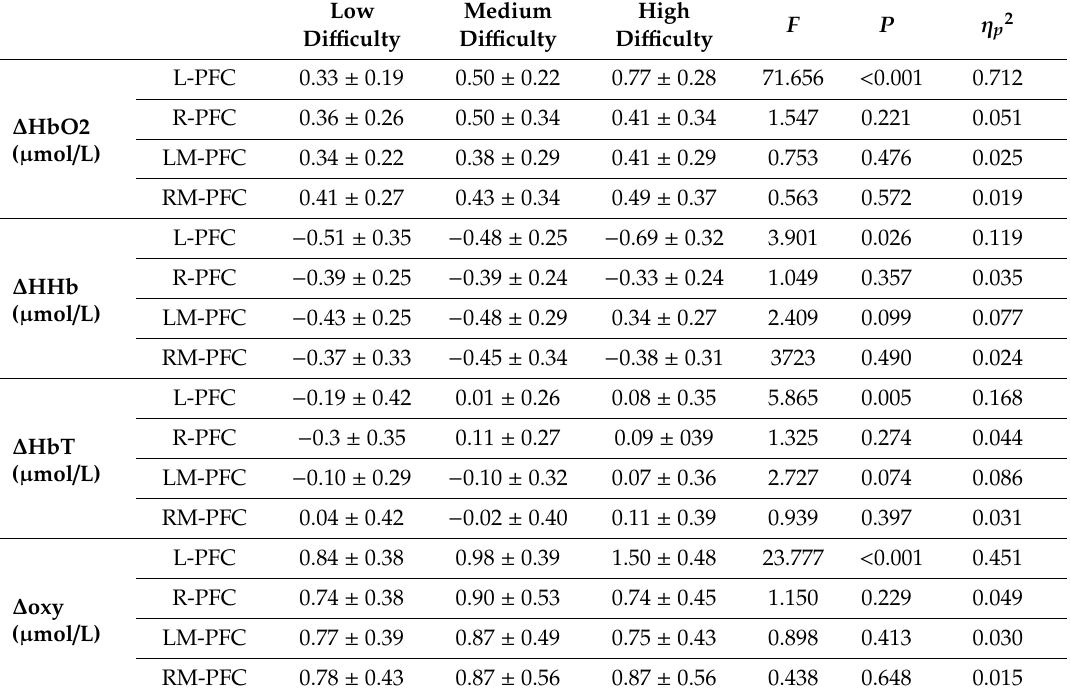
Table 2. Prefrontal cortex dynamics according to the variation of the functional biomarkers in the three problem-solving chess